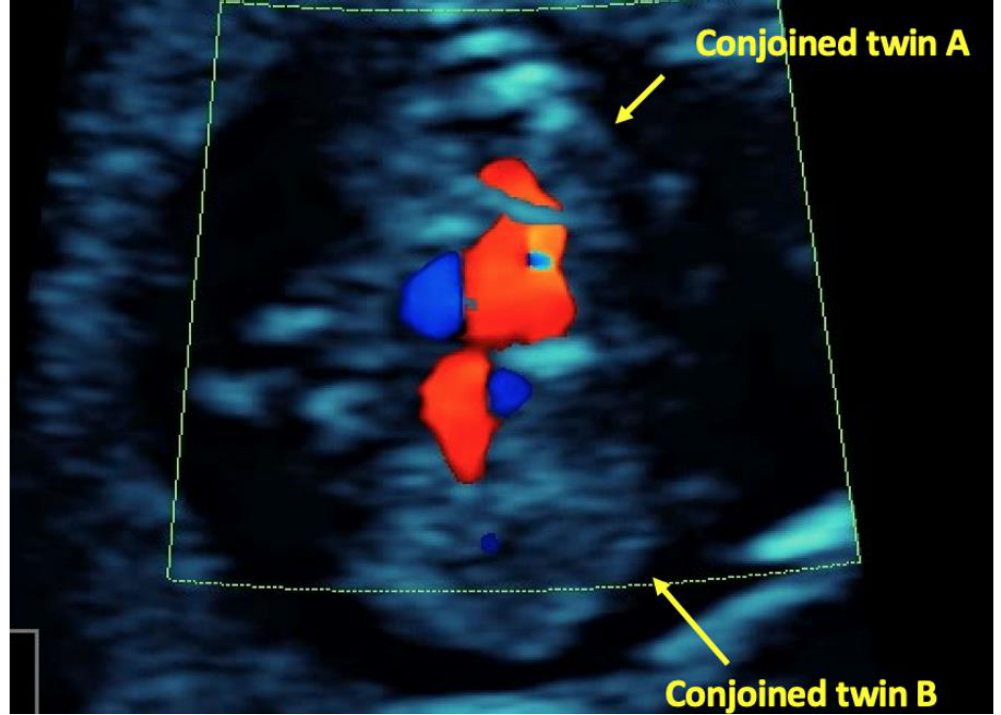
Figure 3. Conjoined twins, transverse plane Color Doppler showing fused cardiac structure.